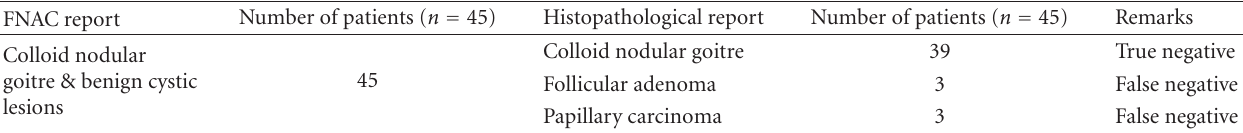
Table 2: Nonneoplastic lesions diagnosed by FNAC and their comparison with histopathological diagnosis.